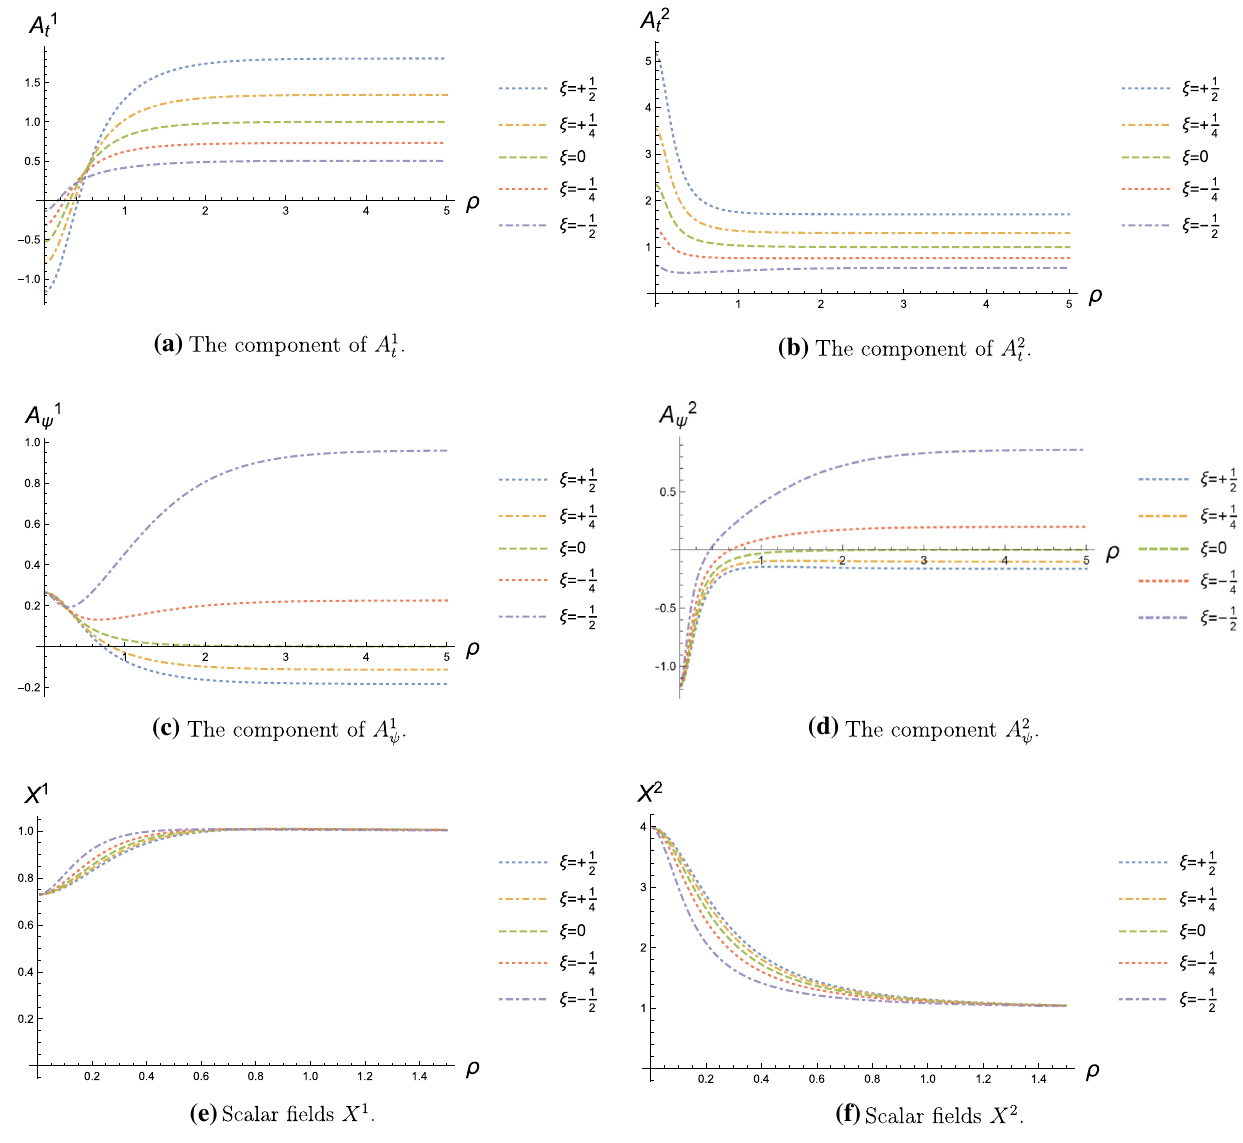
Fig. 5 Components of the gauge fields A I and scalar fields X I at α = 0 . 84, (cid:14) = + 0 . 008 for various